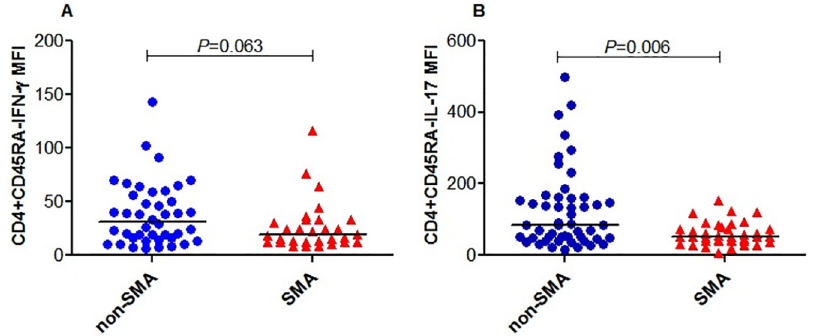
Fig 4. Intensity of IFN- γ and IL-17 production by memory-like CD4+ T-cells. Data are presented as mean fluorescence intensity (MFI). The MFI was determined by FlowJo Software (TreeStar, Ashland, OR, USA). The line in the middle representsthe median value. Betweengroups comparisons in the clinical categories were performed by Mann-Whitney U tests. (A) MFI of IFN- γ in CD4+CD45RA- cells. (B) MFI of IL-17 in CD4 +CD45RA-